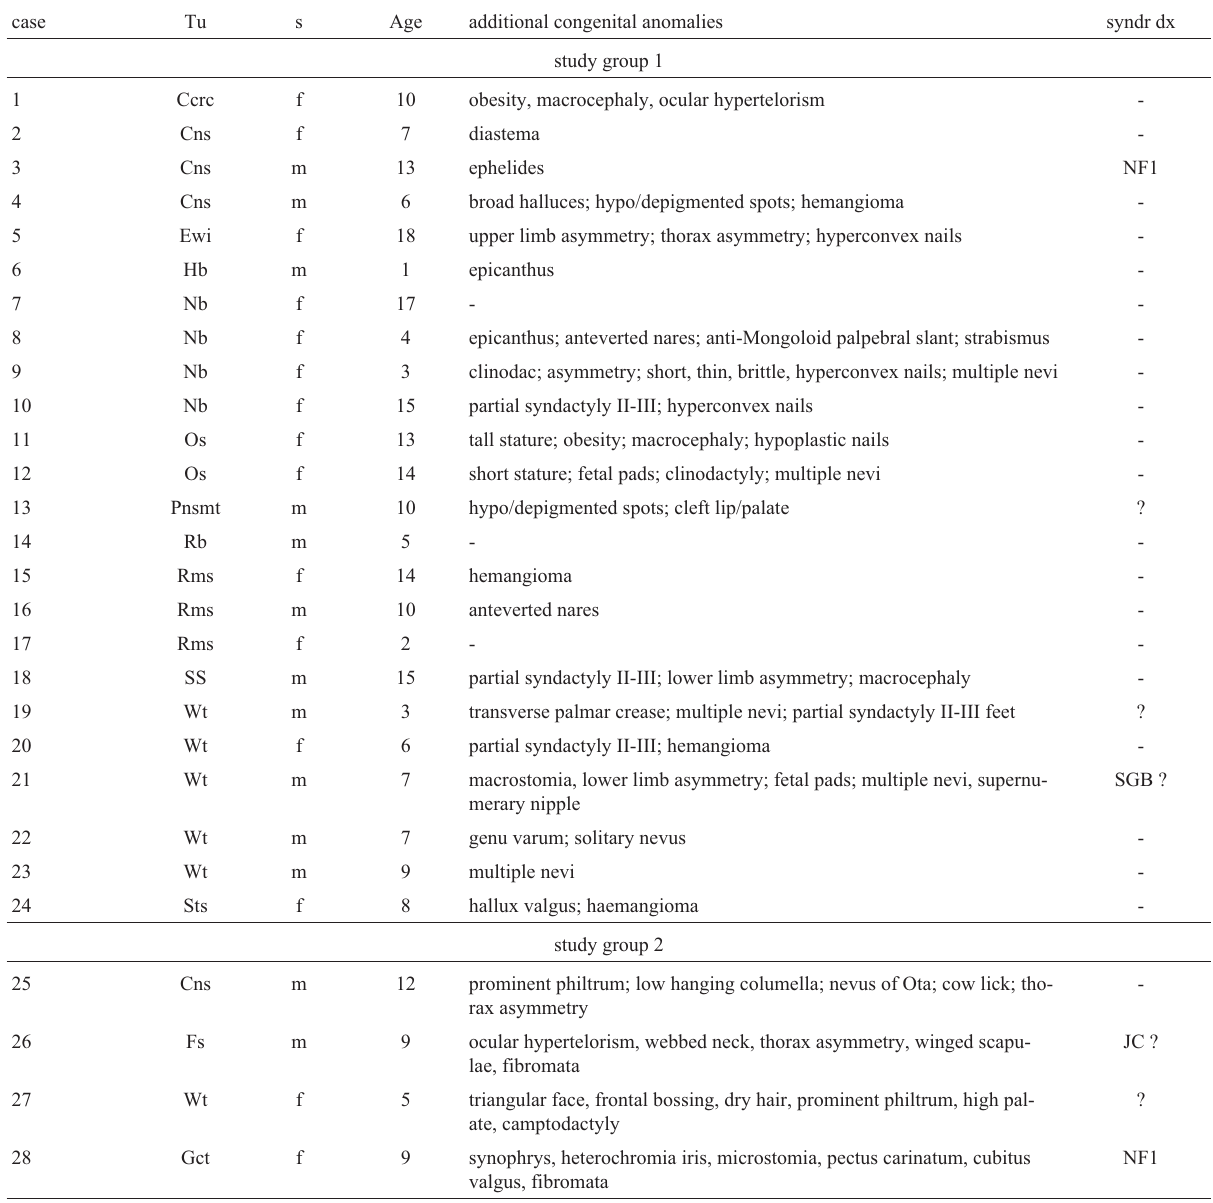
Table 2 - Additional birth defects, congenital anomalies, and morphologic variants detected by ectoscopy in children with pediatric solid tumor and mul- tiple CALMs. Cases are stratified by tumor and by cohort. case